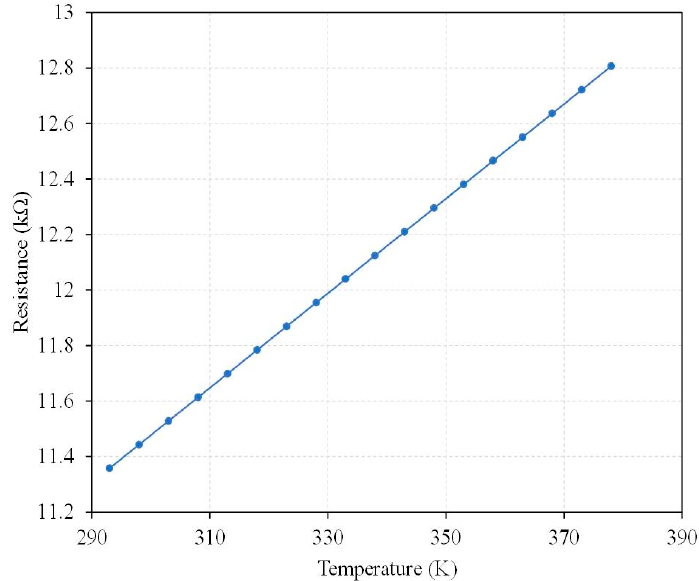
Figure 5. Evaluation of resistance change for the temperature sensor.